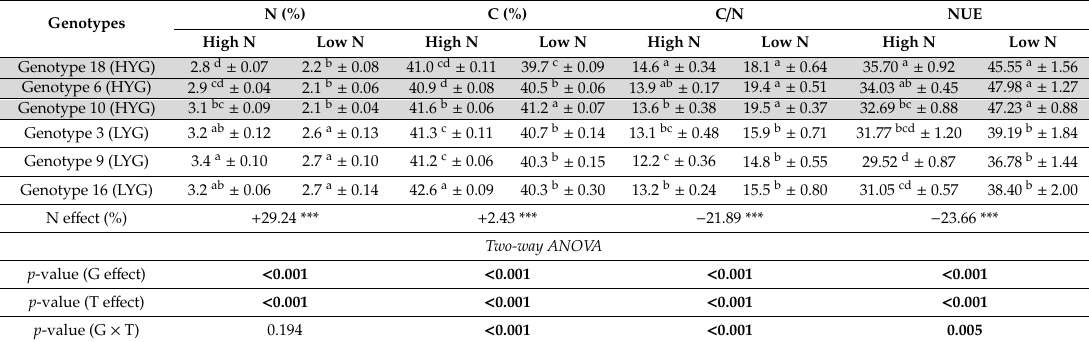
Table 2. Grain nitrogen concentration (N), carbon concentration (C), C / N ratio, and nitrogen use e ffi ciency (NUE) of 6 wheat genotypes fertilized by two nitrogen levels (High and Low). Means are followed by standard error (n =